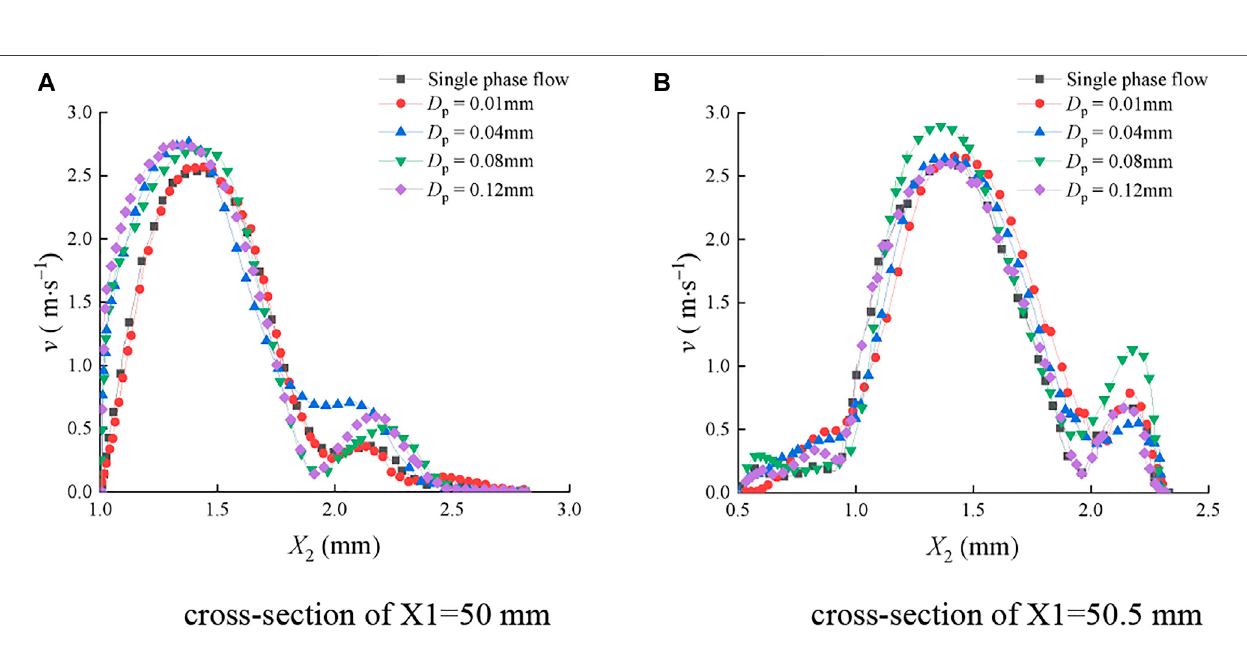
Frontiers in Physics |